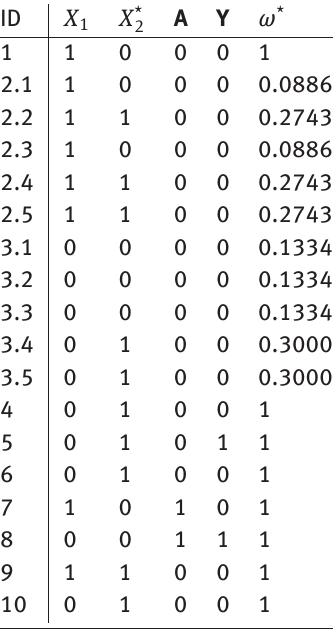
Table A5: Final FI-completed data